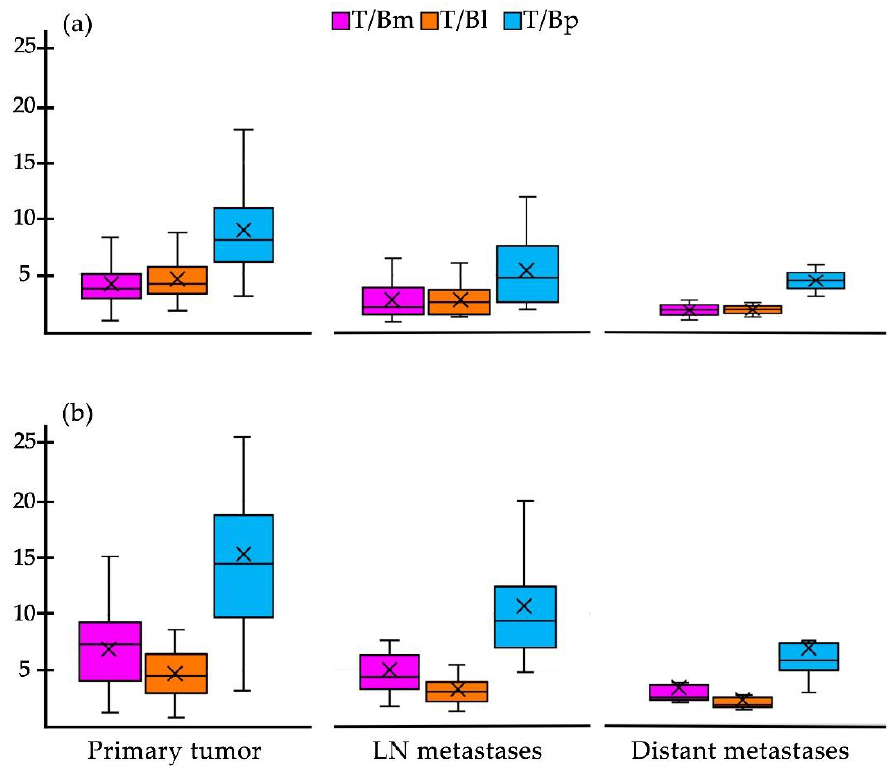
Figure 6. Box plot of the target-to-background ratios of ( a ) [ 99m Tc]Tc-iFAP and ( b ) [ 18 F]F-FDG in all primary tumors, lymph node metastases, and distant metastases (except gliomas).The T/Bp ratio is higher in all categories of both radiotracers, particularly in the primary tumor. T/Bm (tumor/mediastinum), T/Bl (tumor/liver), and T/Bp (tumor/psoas muscle). × = mode.